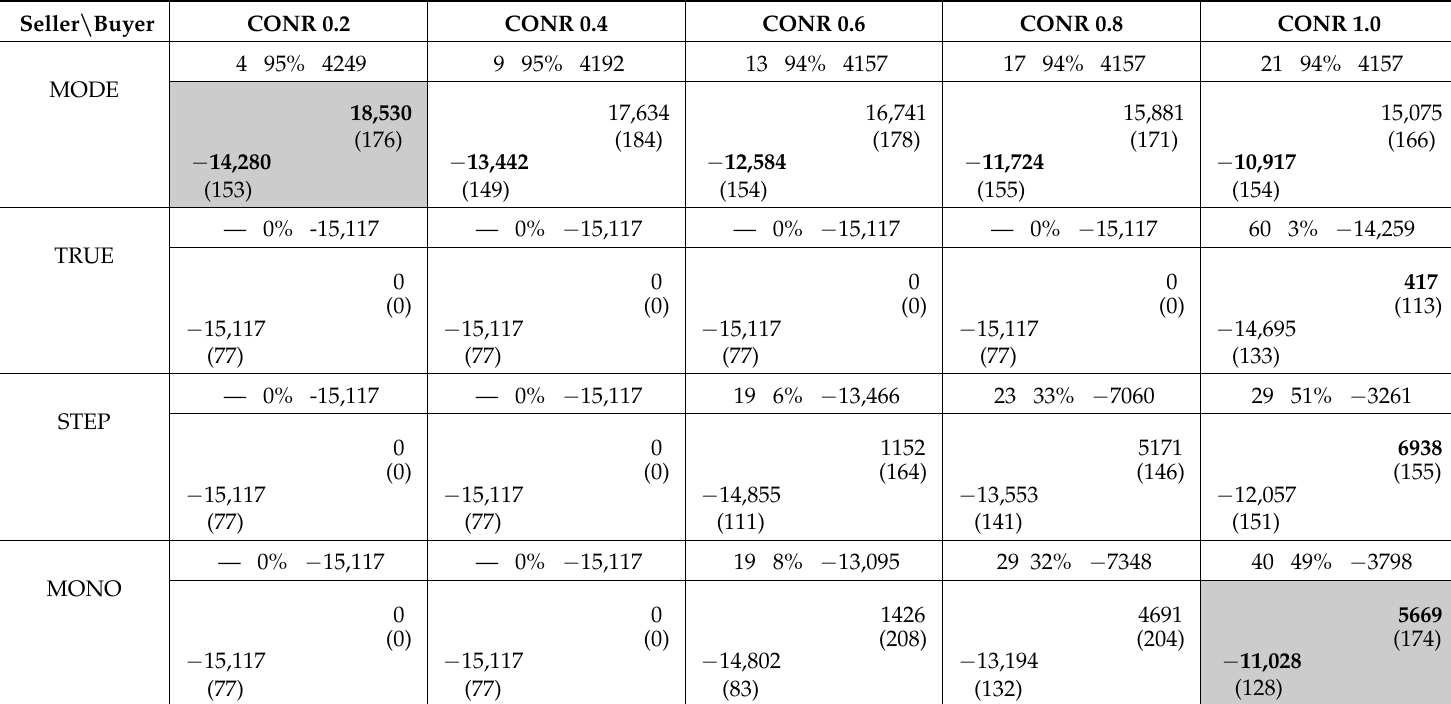
Table 3. Payoff matrix in the high-risk